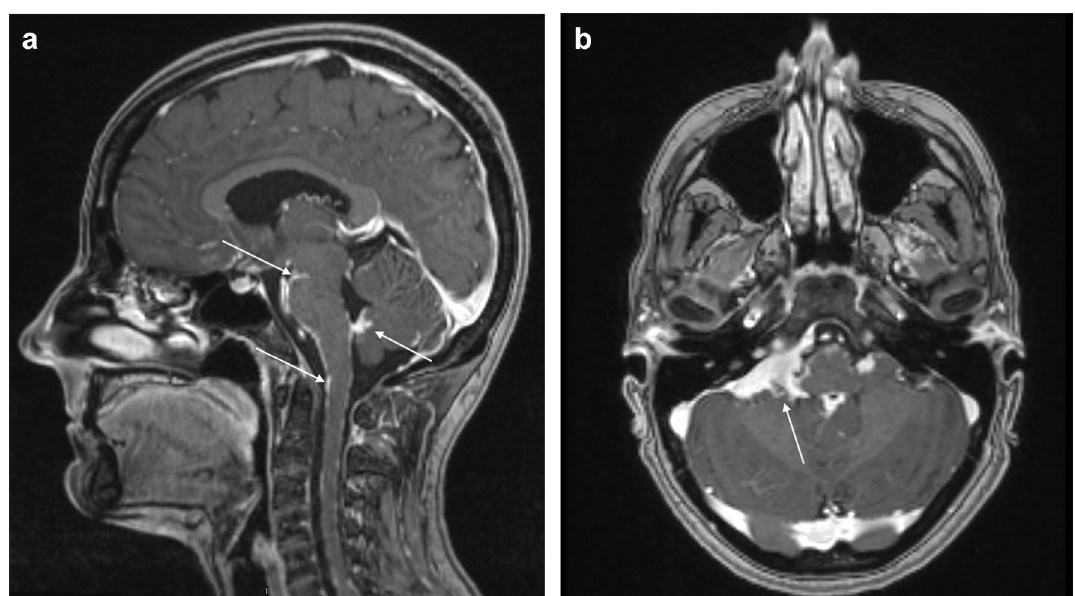
Figure 2. Sarcoidosis in the base of the brain. ( a ) Sagittal T1Gd shows multifocal and diffuse linear leptomeningeal contrast enhancement predominant in the basal cisterns and in the posterior fossa and even along the cervical spinal cord in a 29-year-old woman with definite neurosarcoidosis. ( b ) Axial T1 Gd shows a contrast enhancing extra-axial mass in the right cerebellopontine